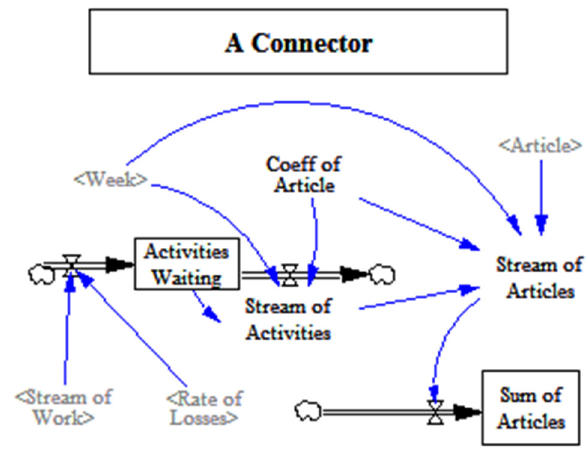
Figure 7. The stochastic and discrete Vensima model of creating and submitting papers.